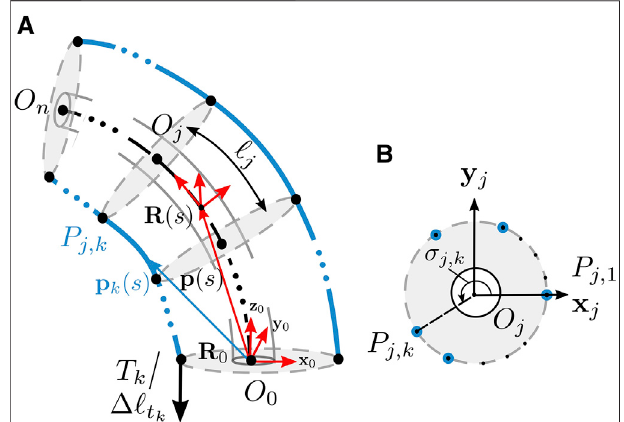
FIGURE4|(A) DiagrammaticrepresentationofonesegmentofaTDCR, actuated by tension T k or tendon displacements Δ ℓ t Dashedlineindicatesthebackbonecentrelinewhilethebluesolidlinesdenote the tendons (B) The k th tendon passes through the j th cross section at P j , k . The tendons are labelled in an anticlockwise manner, arranged radially around the center of the cross section, O j .